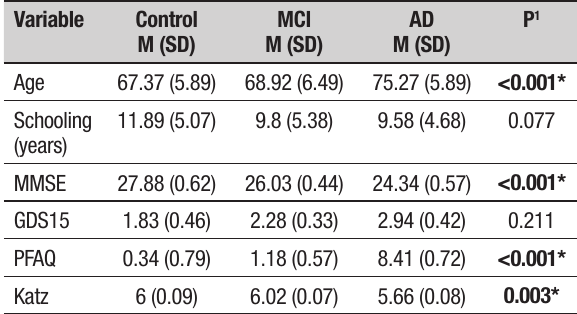
Table 1. Estimated mean values and standard errors of scales, according to group and results of comparisons.